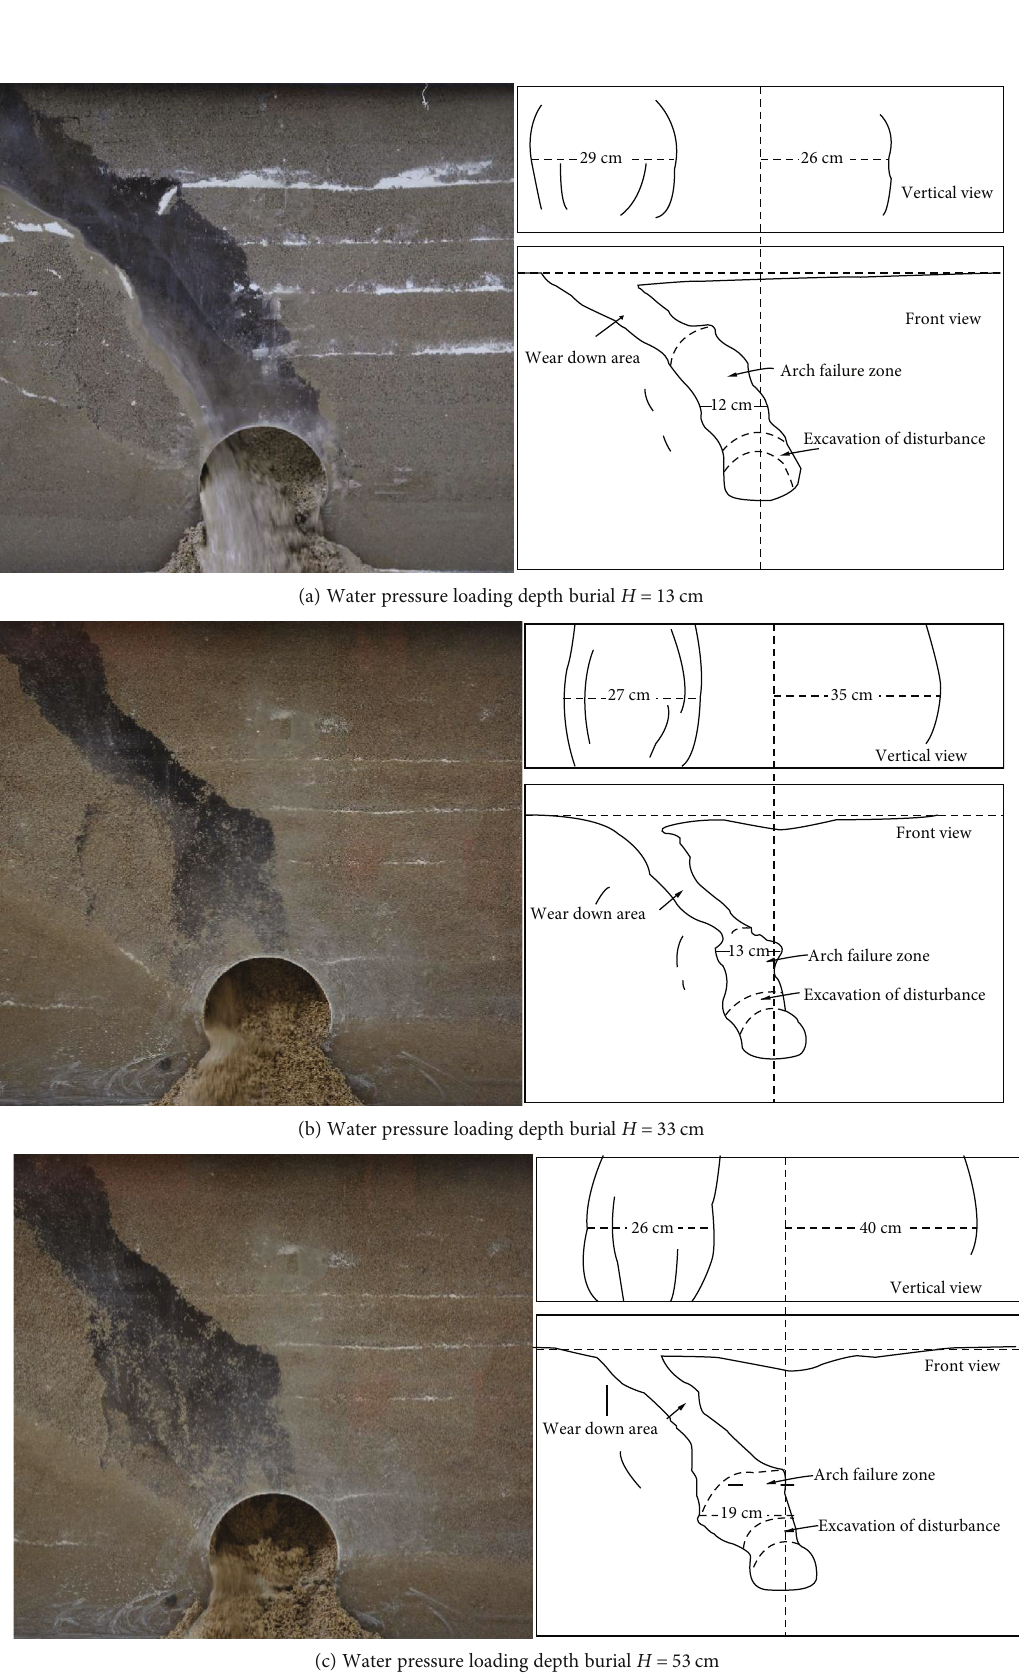
Figure 11: Final failure shapes and their sketches in di ff erent conditions of seepage